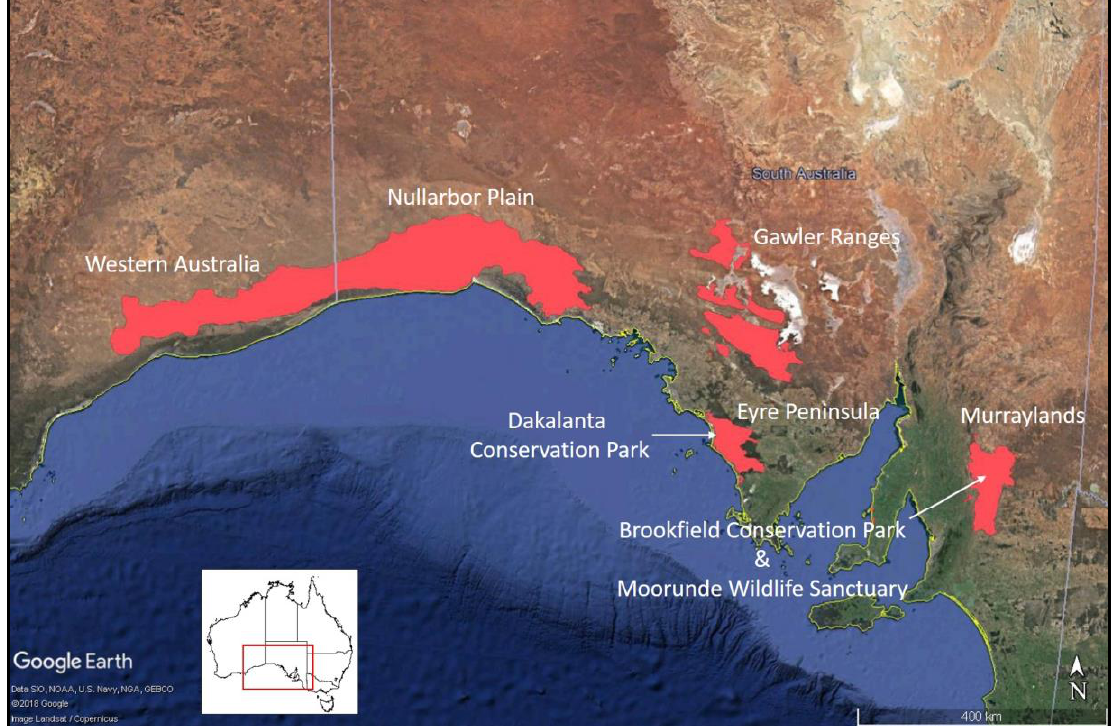
Figure 1. Distribution of southern hairy-nosed wombats as at the most recent assessments in 2016 – 2018